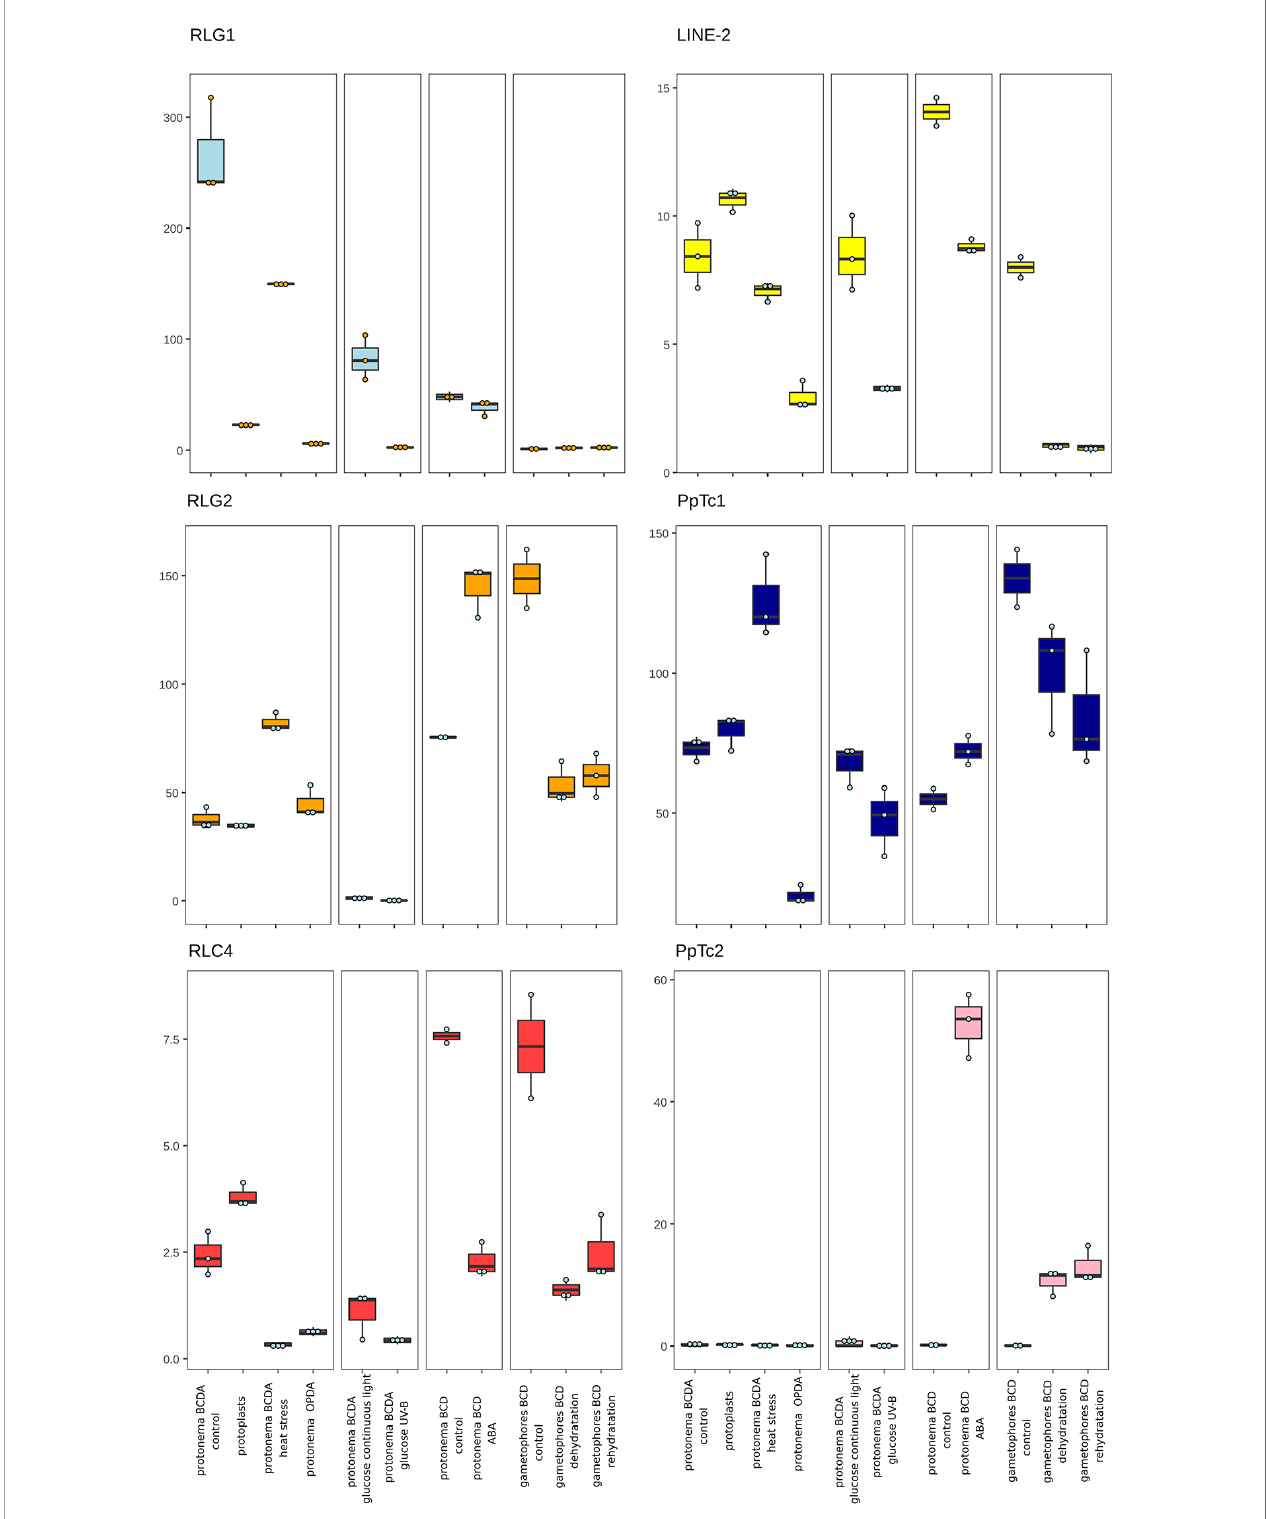
FIGURE 4 | P. patens TE expression under stress conditions. Normalized TE expression (see methods) under different stress conditions selected from the P. patens Gene Atlas library (Perroud et al., 2018).